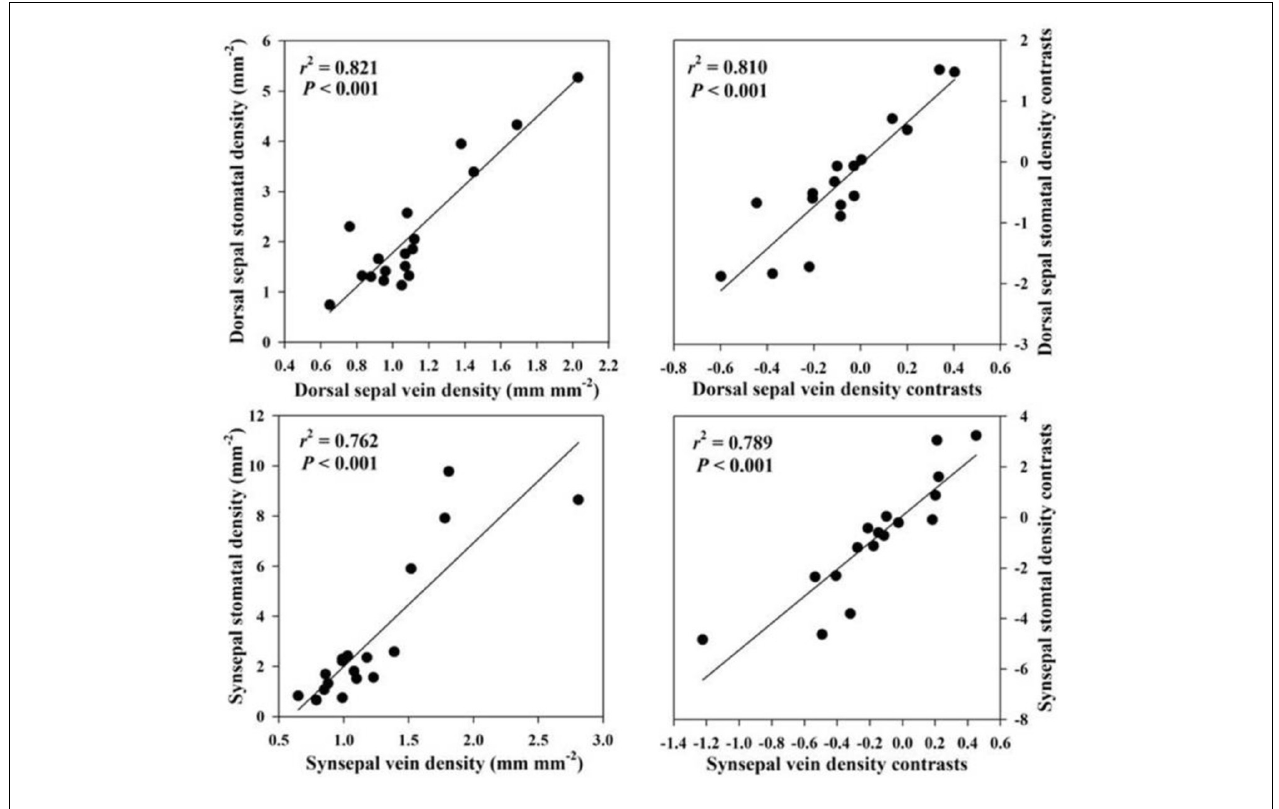
FIGURE 2 | Correlations of vein density with stomatal density in the dorsal sepal and synsepal.